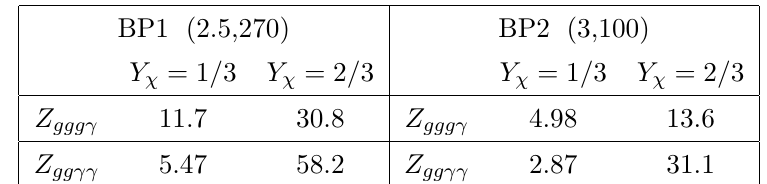
Table 7 . Estimation of signal sensitivities ( Z ) for di(cid:11)erent channels at 3 ab (cid:0) 1 of integrated luminosity for the FCC. We recall that the numbers for the jjj(cid:13) signal is underestimated as the mulit-jet background has not been considered in its